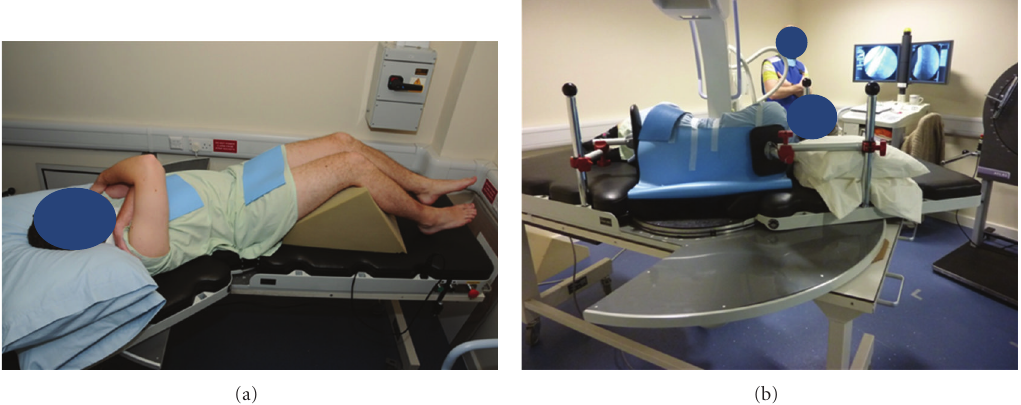
Figure 1: (a) Passive recumbent supine right lateral flexion acquisition. (b) Passive recumbent flexion acquisition.